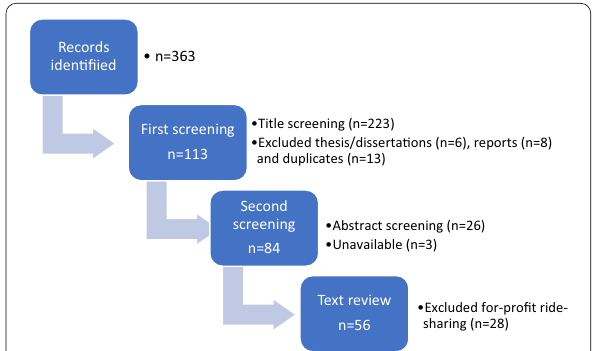
Fig. 2 Number of publications in the review